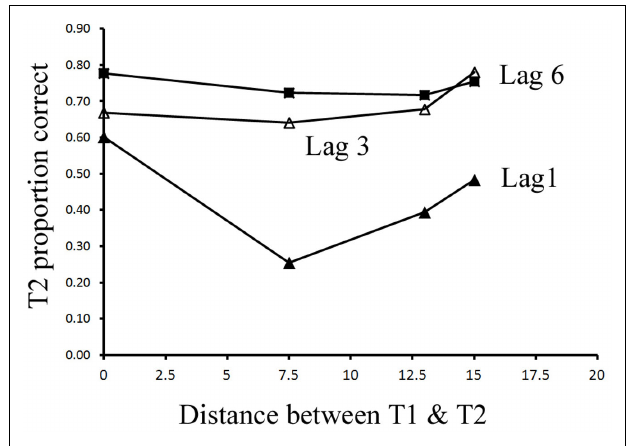
FIGURE 4 | Mean discrimination accuracy ofT2 when participants correctly reportedT1 in Experiment